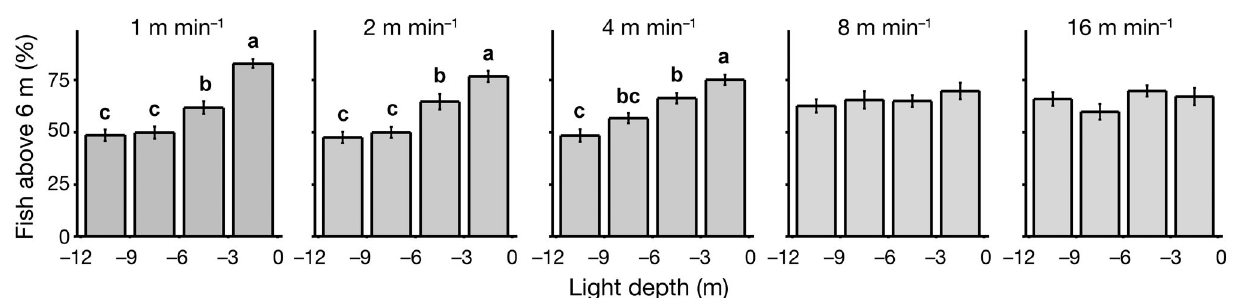
Fig. 2. Mean percentages of Atlantic salmon Salmo salar in the upper 6 m of cages when lights were within 3 m depth incre- ments during movements at 1, 2, 4, 8 and 16 m min −1 . Letters indicate significantly (p < 0.05) different groups from post-hoc (Tukey HSD) comparisons following significant ANOVA